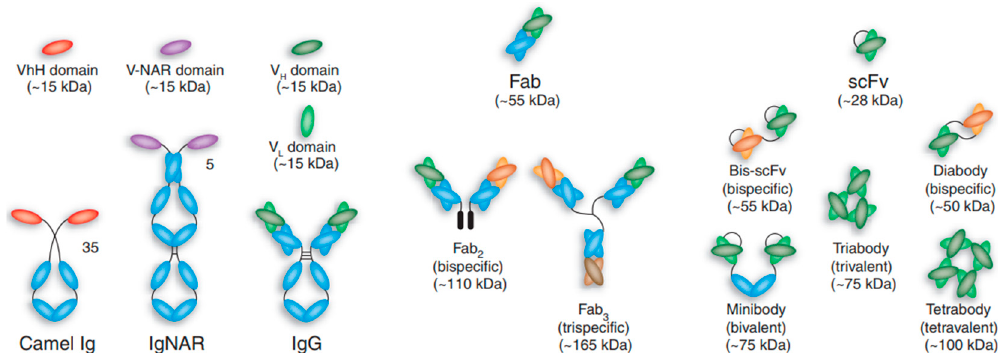
Figure 2. Schematic representation of different antibody formats, showing intact ‘classic’ IgG molecules alongside camelid VhH-Ig and shark Ig-NAR immunoglobulins. Camelid VhH-Ig and shark Ig-NARs are unusual immunoglobulin-like structures comprising a homodimeric pair of two chains of V-like and C-like domains (neither has a light chain), in which the displayed V domains bind target independently. Shark Ig NARs comprise a homodimer of one variable domain (V-NAR) and five C-like constant domains (C-NAR). A variety of antibody fragments are depicted, including Fab, scFv, single-domain VH, VhH and V-NAR and multimeric formats, such as minibodies, bis-scFv, diabodies, triabodies, tetrabodies and chemically conjugated Fab’ multimers (sizes given in kilodaltons are approximate). Reprinted with permission from Nature Biotechnology, 2005. 23: p. 1126. [25].